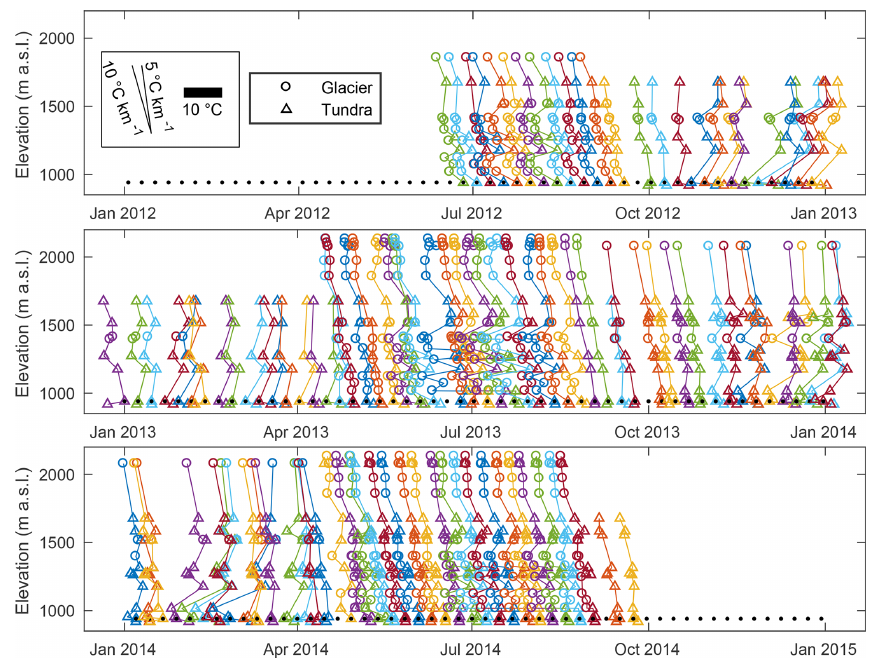
Figure 11. Weekly air temperature profiles show the winter inversions and summer differences between glacier and tundra temperature. For each week, the reference station (Windy Creek Lower, 940ma.s.l., triangles and black dots) was plotted on the horizontal axis according to the date. The other stations (triangles or circles) were plotted to the left or right of the reference station according to their temperature difference. Stations with significant data gaps in a week were not plotted. Many glacier stations were removed in winter due to